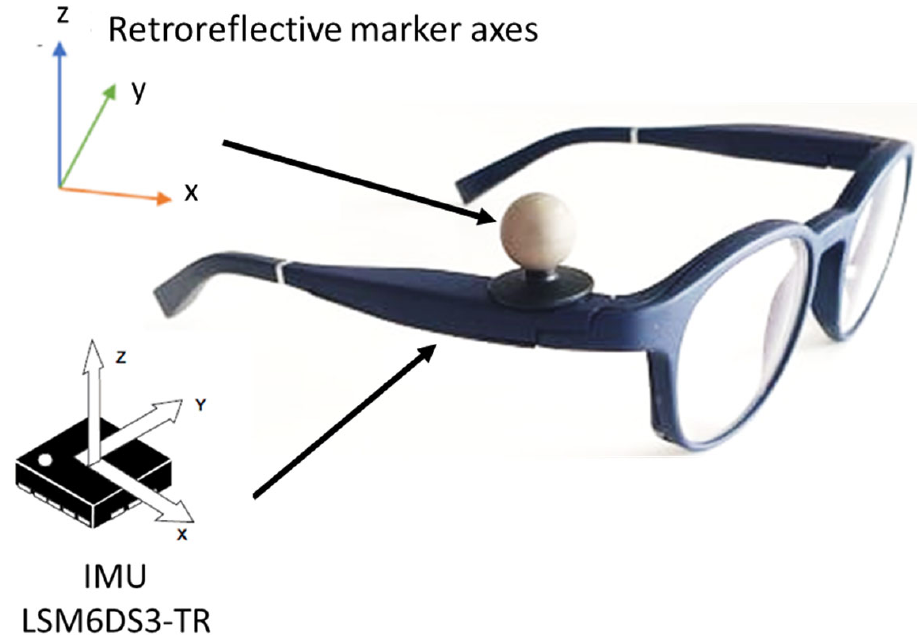
Figure 2. Position of the retroreflective marker on the right arm of the glasses and axes of the IMU and retroreflective marker.